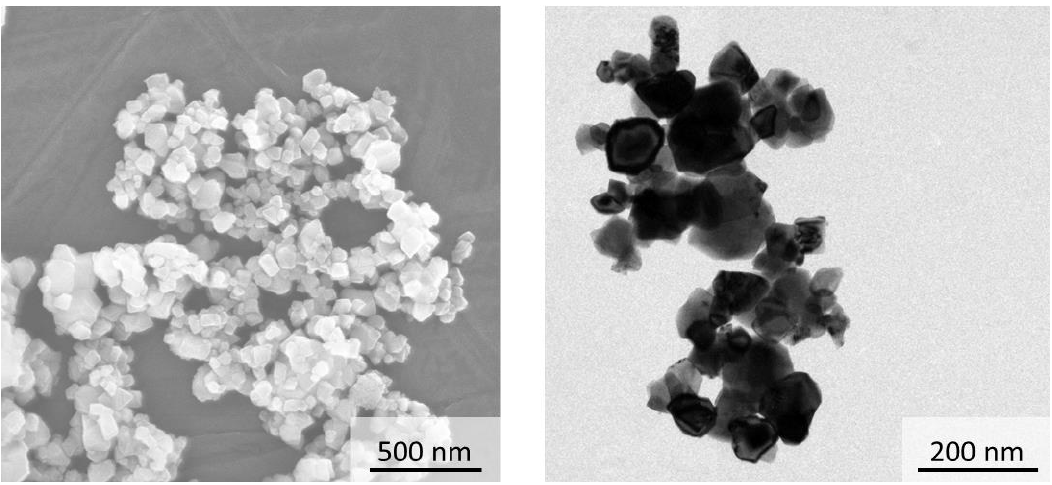
Figure 1. Morphology of GDC10-HP powder: (a) Scanning Electron Microscopic (SEM) image; (b) Transmission Electron Microscopic (TEM) image.